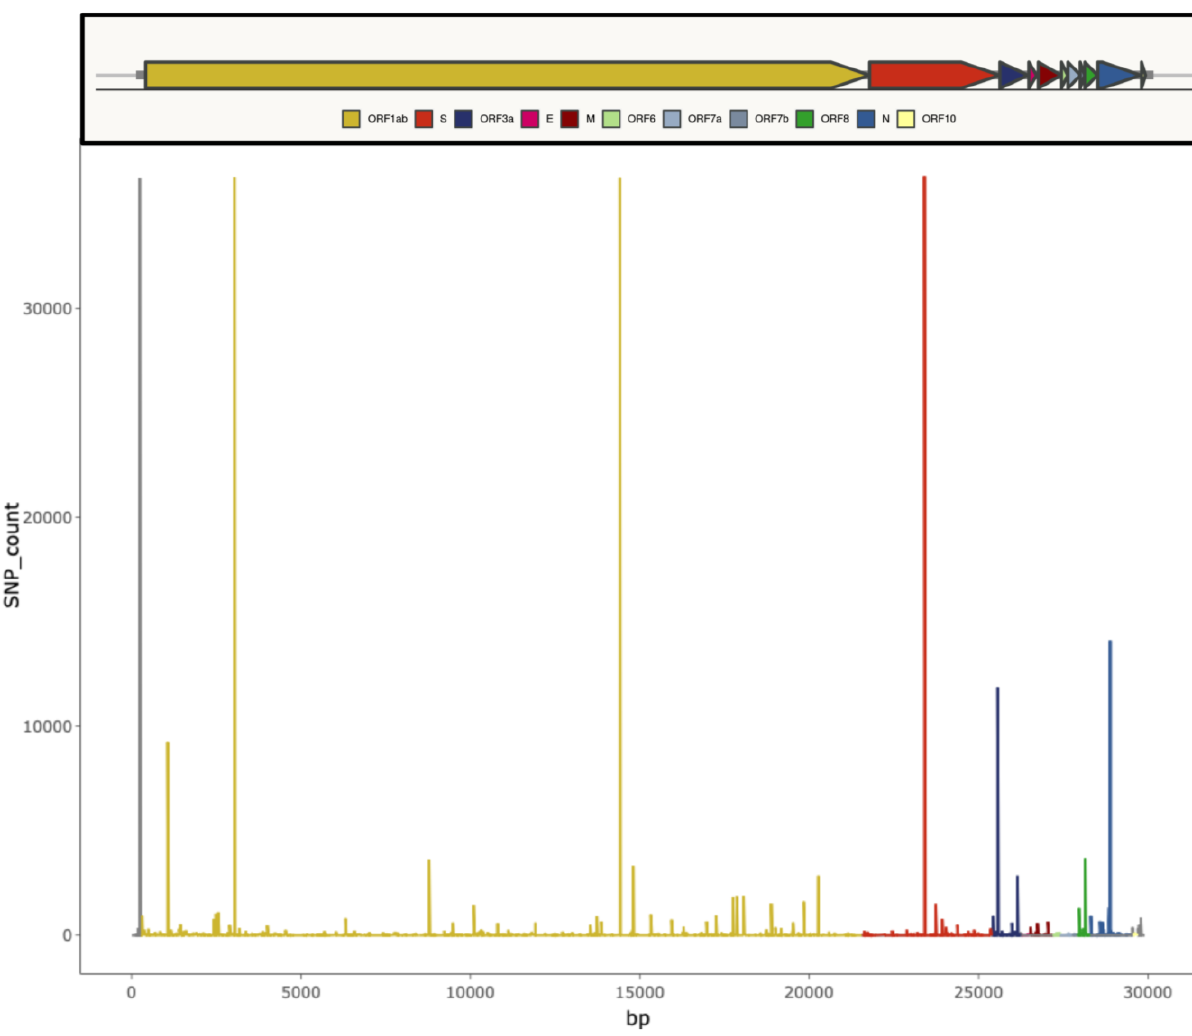
Figure 1. Graphical representation of SARS-CoV-2 genomic diversity derived from the alignment of 46,723 genomes obtained from different locations worldwide (from [18]). Vertical bars indicate the number of single nucleotide polymorphisms (SNPs) found for each genome position.